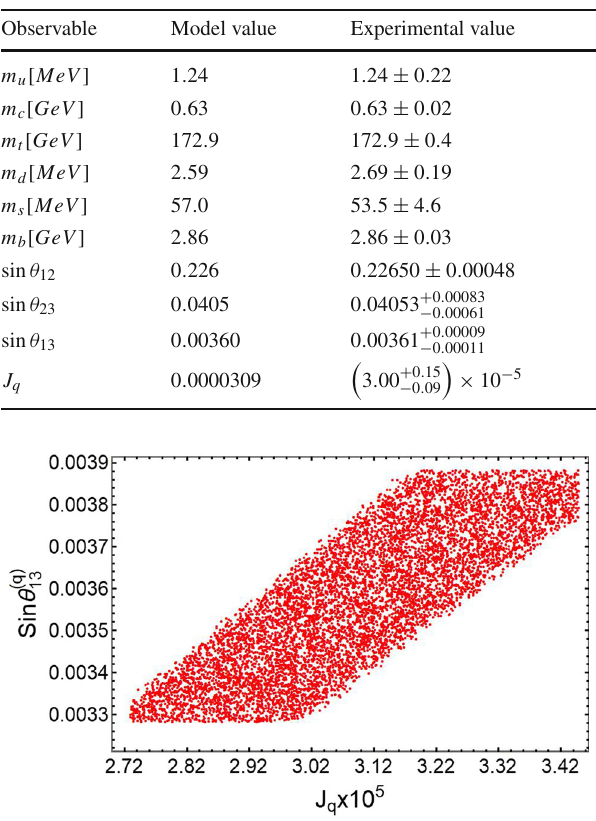
Fig. 1 Correlation plot between the quark mixing parameter sin θ 13 and the Jarlskog